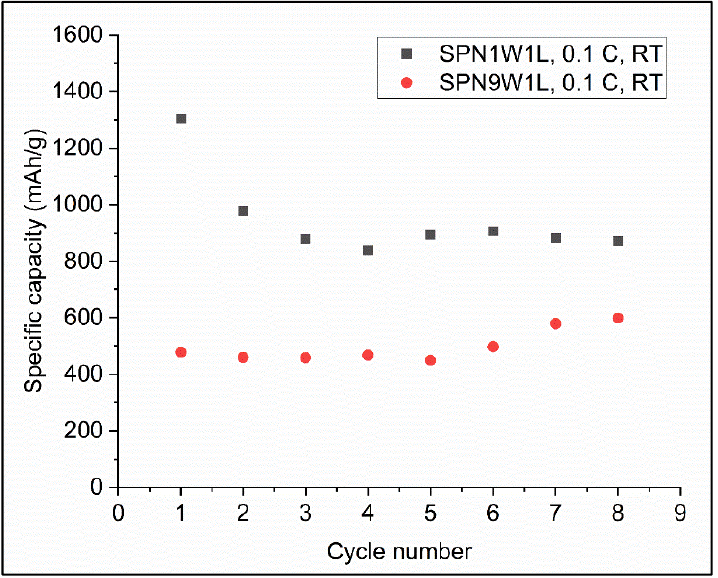
Figure 4. Specific capacity vs. cycle number of the SPNWL, Ni/W = 1:1 and the SPNWL, Ni/W = 9:1. The cells were operated under C/10 at room temperature.